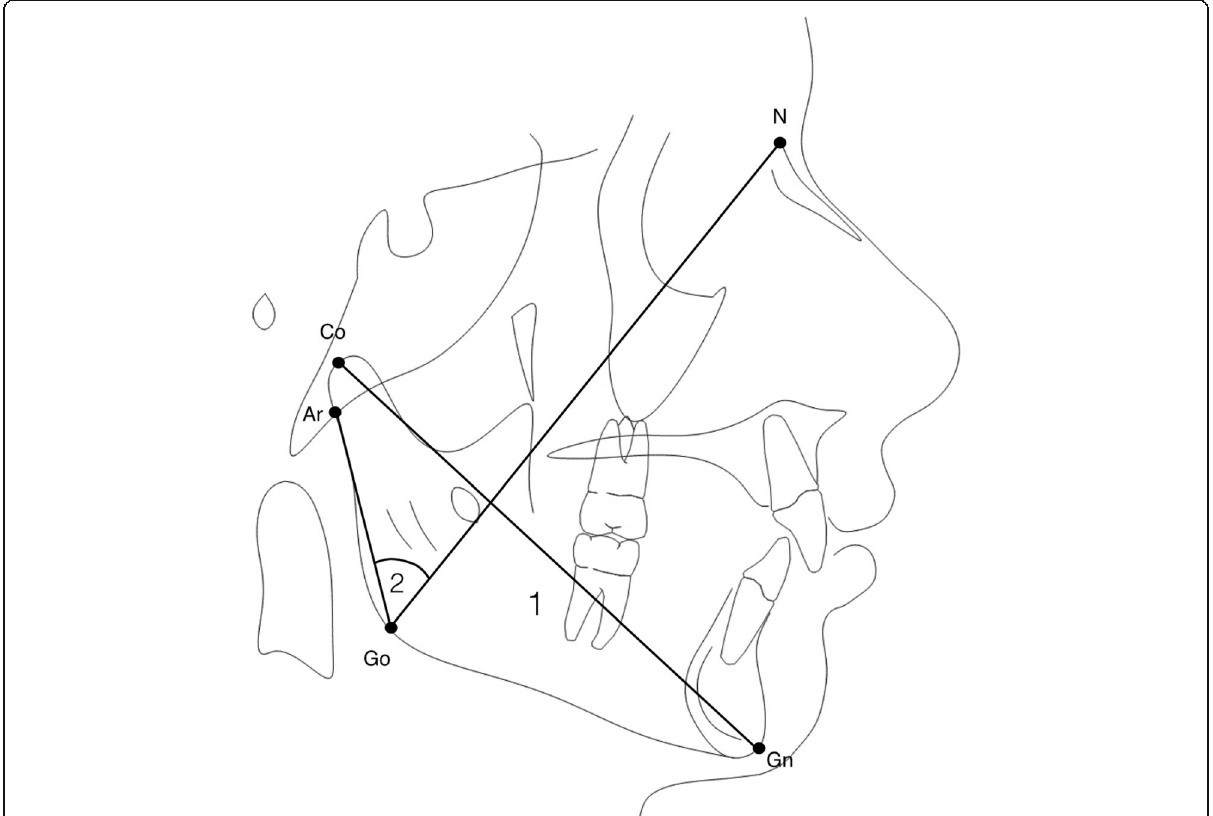
Fig. 4 Predictive measurements of successful improvement of Class II after RME treatment. 1 mandibular length (Co-Gn), 2 superior gonial angle (Ar^Go^N)